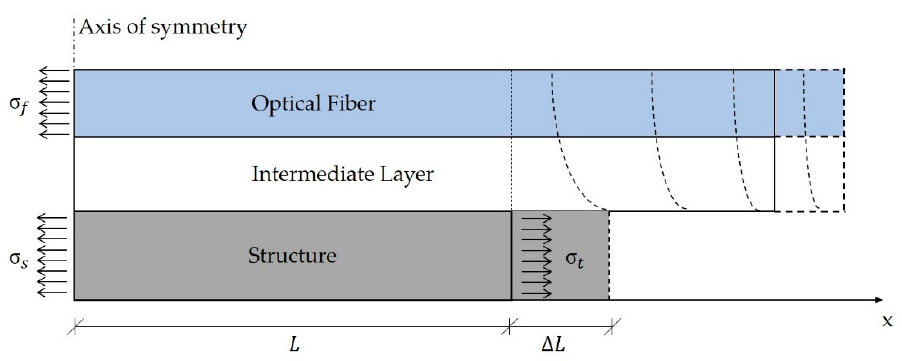
Figure 3. Optical cable response to a ∆𝐋 deformation of the structure.